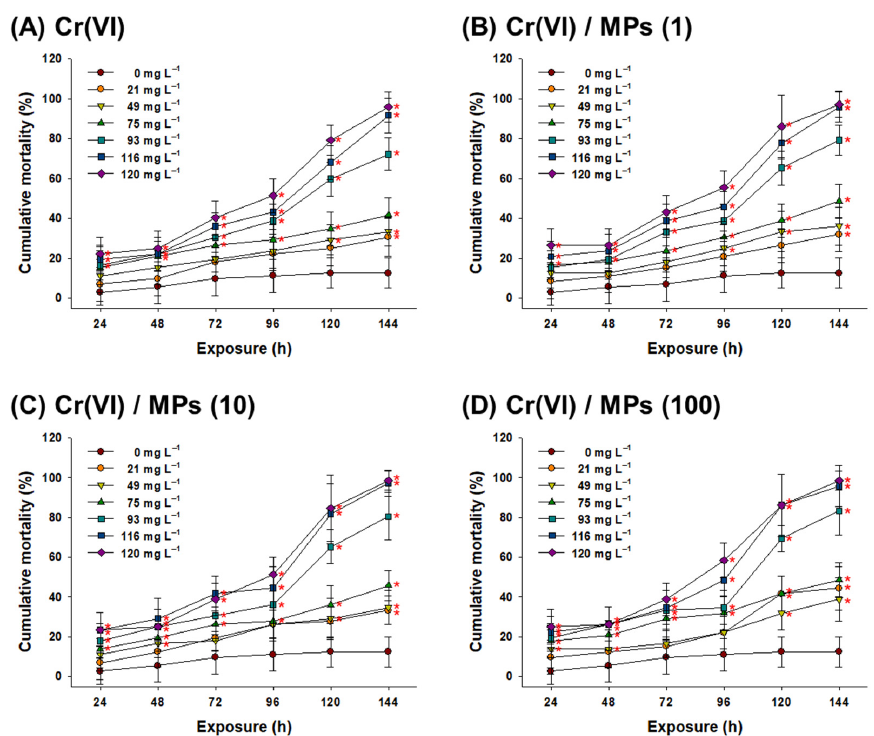
Figure 5. Results of acute toxicity in zebrafish. Cumulative mortality of zebrafish embryos and larvae in response to different concentrations of ( A ) Cr(VI), ( B ) Cr(VI) + 1 μ m MPs (1 particle L − 1 ), ( C ) Cr(VI) + 1 μ m MPs (10 particles mL − 1 ), and ( D ) Cr(VI) + 1 μ m MPs (100 particles L − 1 ) for 144 h. Data are presented as mean ± standard deviation (S.D.) of twelve replicates (n = 6 per replicate). An asterisk (*) on each concertation or day indicates a significant difference between the control and exposure groups ( p < 0.05). Table 1. Cumulative mortality of zebrafish embryos and larvae measured in response to different concentrations of Cr(VI) with 1 μ m MPs (1, 10, and 100 particles L − 1 ) for 144 h. MPs Conc. Cr(VI) Conc. (Particles L − 1 ) (mg L − 1 )